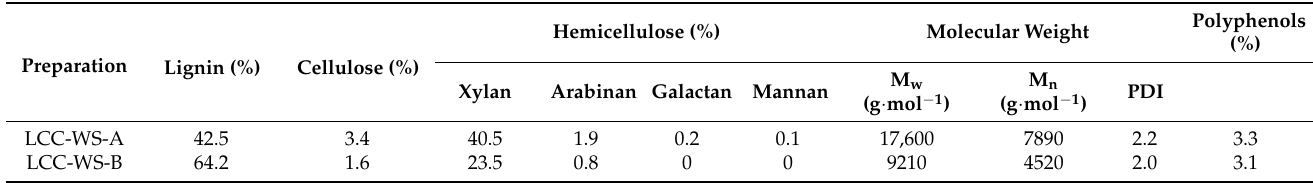
Table 1. Composition and molecular weight of LCC-WS-A and